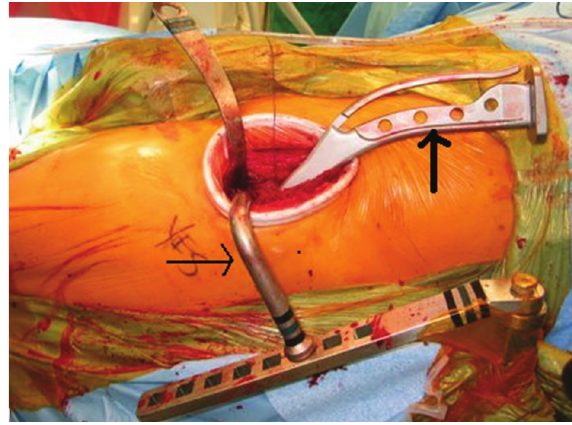
Figure 3: Intraoperative photograph illustrating the use of the femoral hook attachment (thin arrow) and curved broach handle (thick arrow), used to prepare the